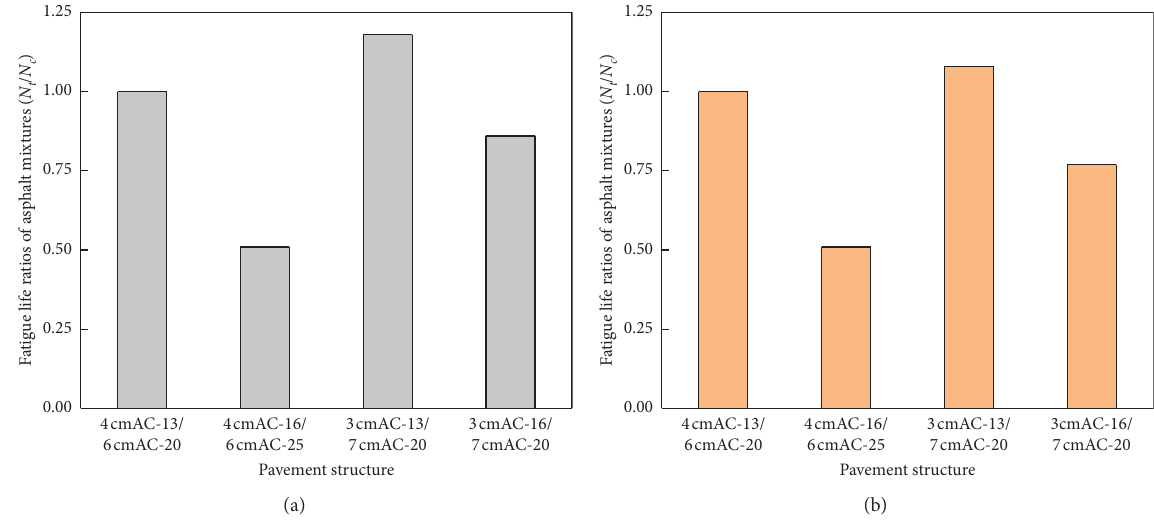
Figure 7: Ratio of the fatigue life of specimens with different pavement structure combinations to the 4-cm AC-13 surface layer/6-cm AC-20 bottom layer pavement structure combination. (a) Failure probability � 5%. (b) Failure probability �